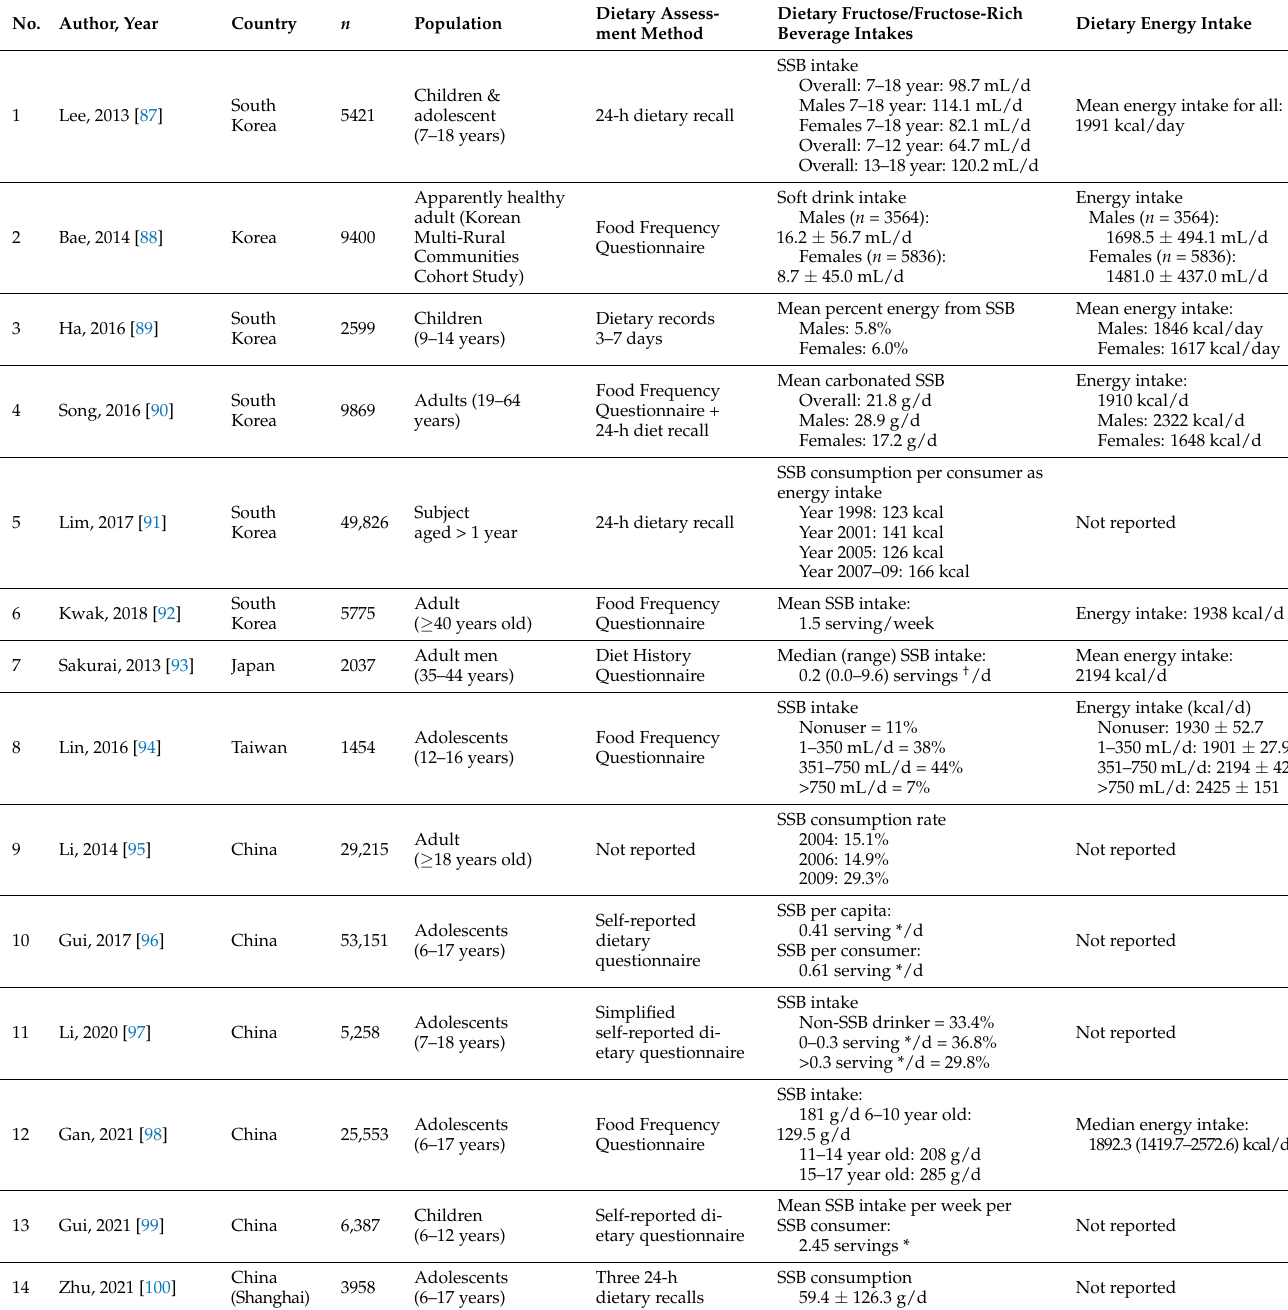
Table 3. Fructose intake as sugar-sweetened beverages in Asian